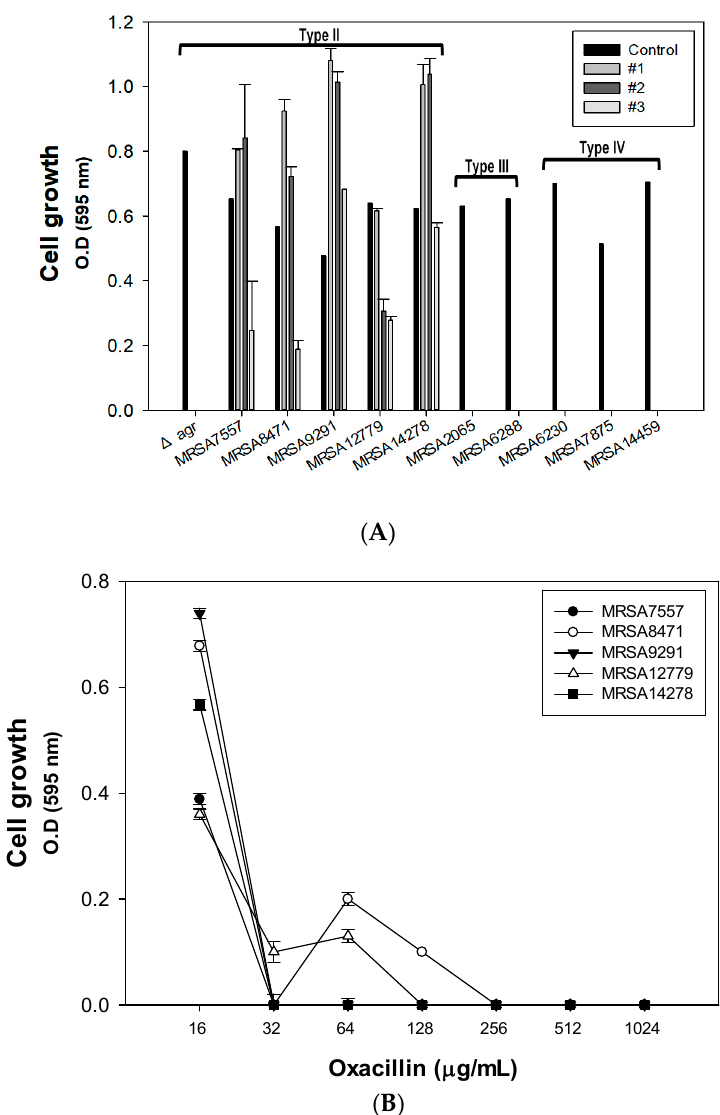
Figure 4. Validation of optimized condition and MIC calculation for clinical isolates with a high level of antibiotic resistance. ( A ) The effect of combination therapy on methicillin ‐ resistant Staphylococcus aureus (MRSA) using optimized condition #1 (oxacillin = 15 μ g/mL, palmitic acid = 1.3 mg/mL, and span85 = 0.1% ( v / v )), #2 (oxacillin = 50 μ g/mL, palmitic acid = 1 mg/mL, and span85 = 0.08% ( v / v )), and #3 (oxacillin = 100 μ g/mL, palmitic acid = 0.3 mg/mL, and span85 = 0.4% ( v / v )). ( B ) Treatment of the clinically isolated SCCmec type II strains using condition #1 (palmitic acid = 1.3 mg/mL and span85 = 0.1% ( v / v )) with variations in the oxacillin concentration. The error bars represent the standard deviation of three replicates.